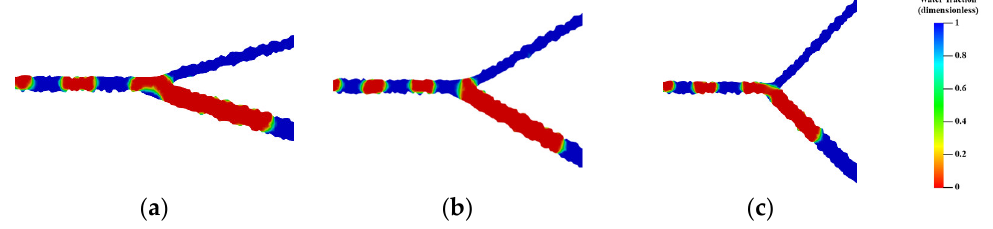
Figure 17. Snapshots of the phase distribution for the Y-shaped junction models with intersecting angles of ( a ) 30°; ( b ) 60°; and ( c ) 90°.